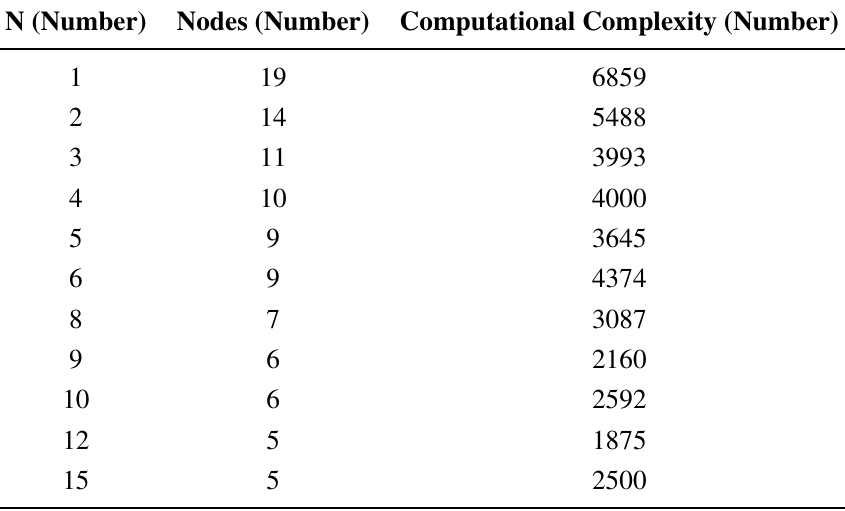
Table 1. Examples of the different separating